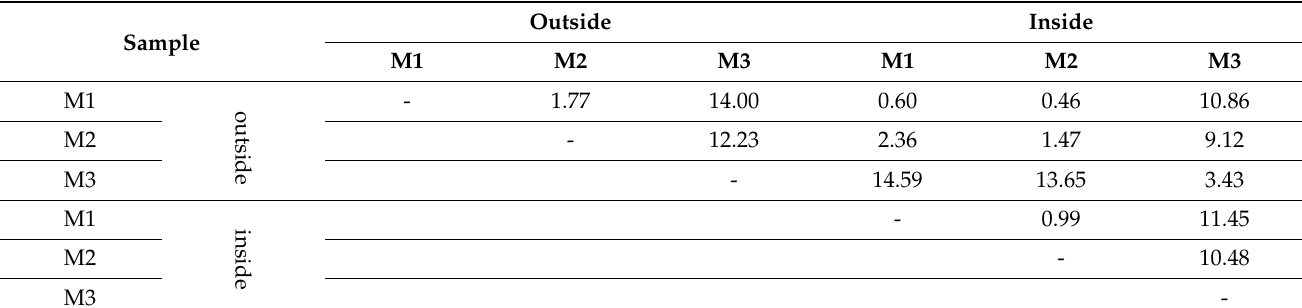
Table 2. The CIE L*a*b* color differences of margarine